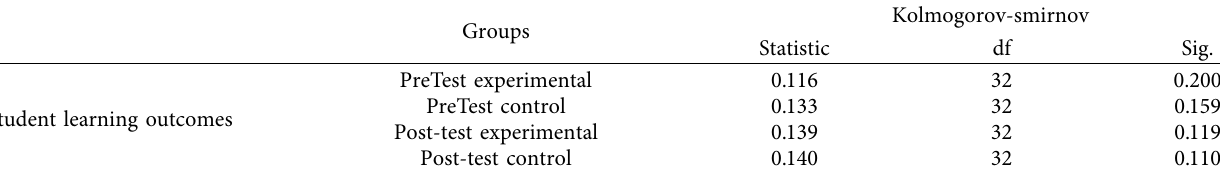
Table 2: Results of test of normality.